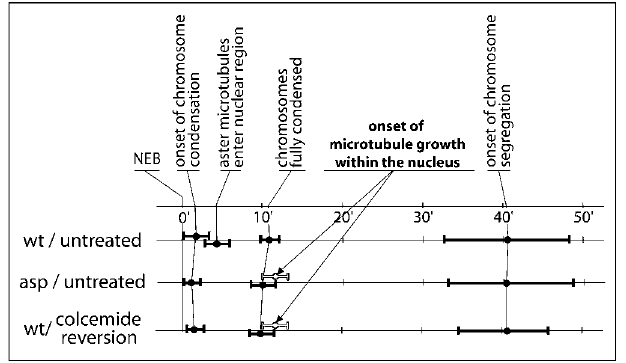
Figure 3. The Timing of Noncentrosomal Microtubule Nucleation Referred to NEB (timepoint 0), the timing of chromosome con- densation and of onset of chromosome segregation is essentially identical in control, asp , and colcemid-treated spermatocytes. In control spermatocytes, aster microtubules can be seen entering the nuclear region 3–6 min after NEB. They do not in asp or following colcemid treatment. In these two cases, however, centrosome- independent microtubule polymerisation can be seen over the nuclear region. It starts between 9 and 13 min after NEB, coinciding with or very shortly after the end of chromosome condensation. DOI: 10.1371/journal.pbio.0020008.g003